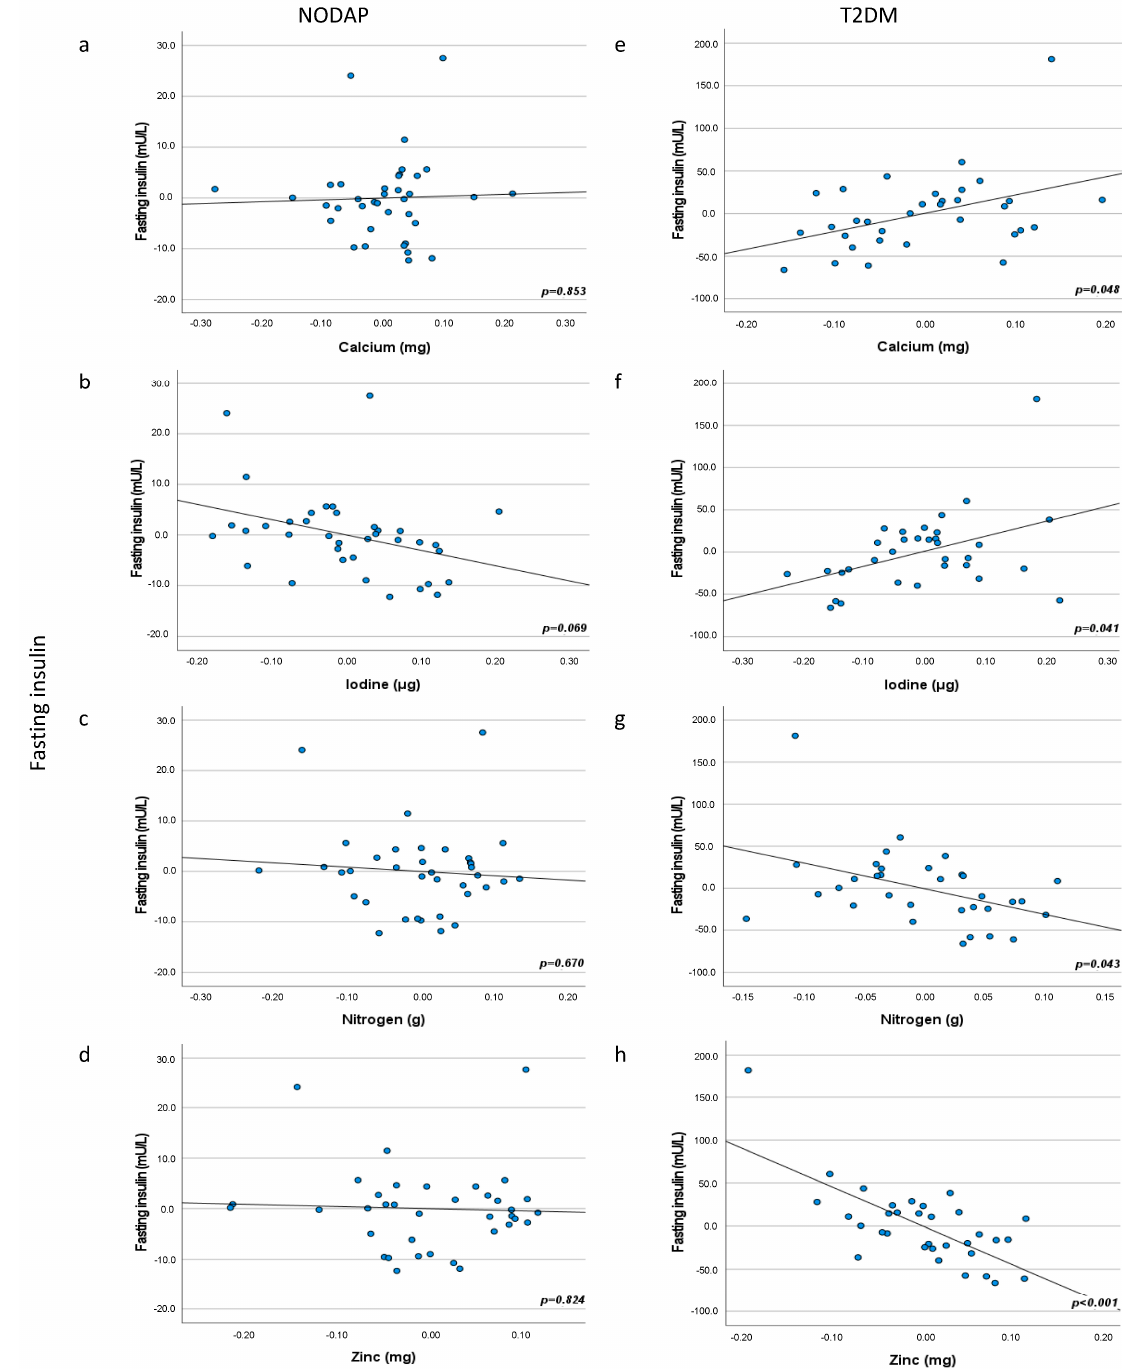
Figure 2. Associations between calcium, iodine, nitrogen, and zinc intake and fasting insulin in NODAP ( a – d ) and T2DM ( e – h ). Abbreviations: NODAP = New-onset diabetes or prediabetes after acute pancreatitis. T2DM = Type 2 diabetes or prediabetes prior to acute pancreatitis. HbA1c = glycated haemoglobin. Calcium, iodine, nitrogen, and zinc data were log transformed. Partial regression plots were adjusted for age, sex, daily energy intake, V/S fat volume, alcohol intake, smoking status, aetiology of AP, number of AP episodes, cholecystectomy, use of antidiabetic medications. Significance was set at p < 0.05.